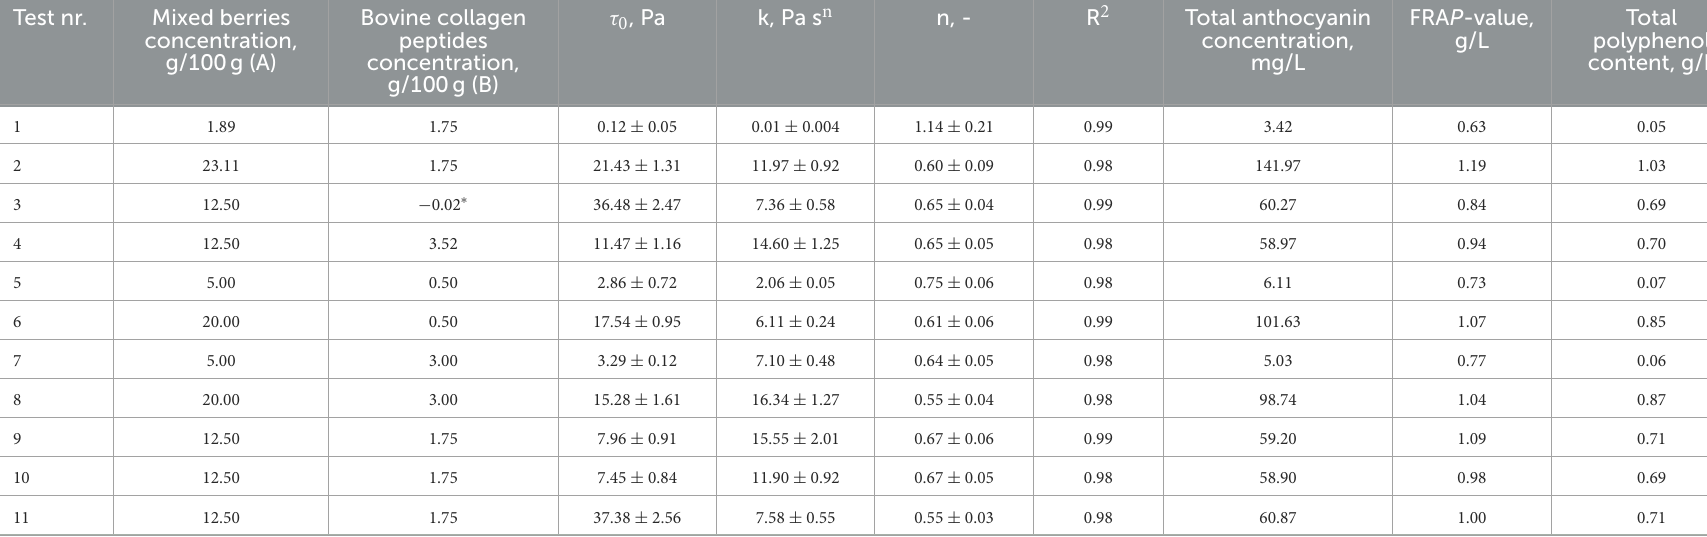
TABLE 3 Experiment design [central composite rotational design (CCRD)] and factor levels with actual values, and measured results of Herschel-Bulkley model and bioactive compounds ( ∗ is a theoretically calculated value, 0/100g bovine collagen peptides were added). Test nr.